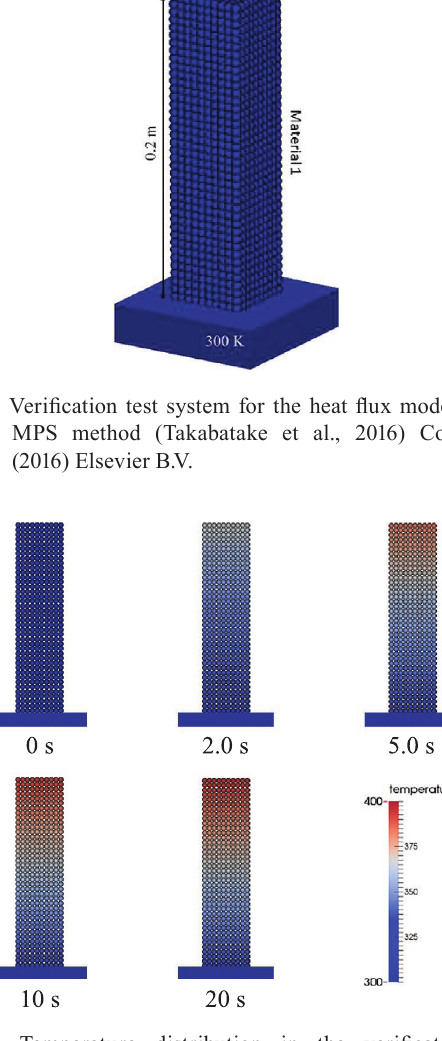
Fig. 10 Temperature distribution in the verification test (Takabatake et al., 2016) Copyright: (2016) Elsevier